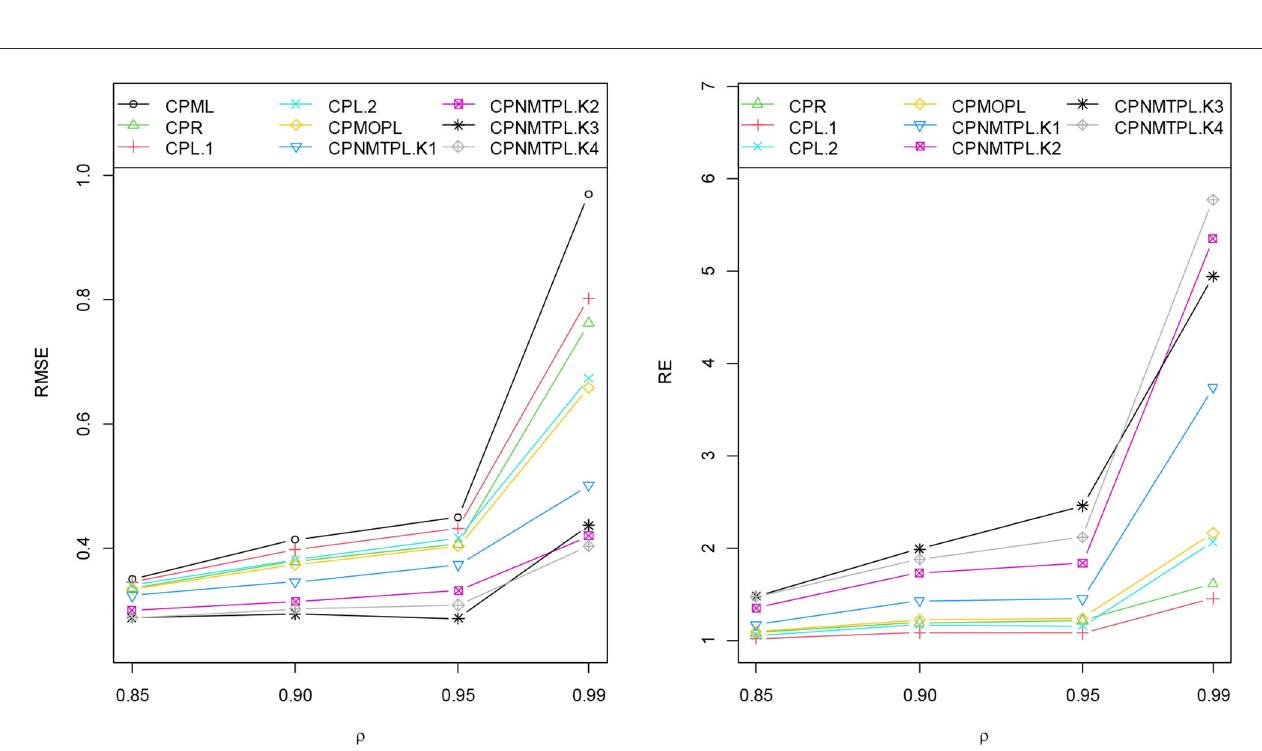
FIGURE3 RMSE and RE categorized by levels of the correlation degree between explanatory